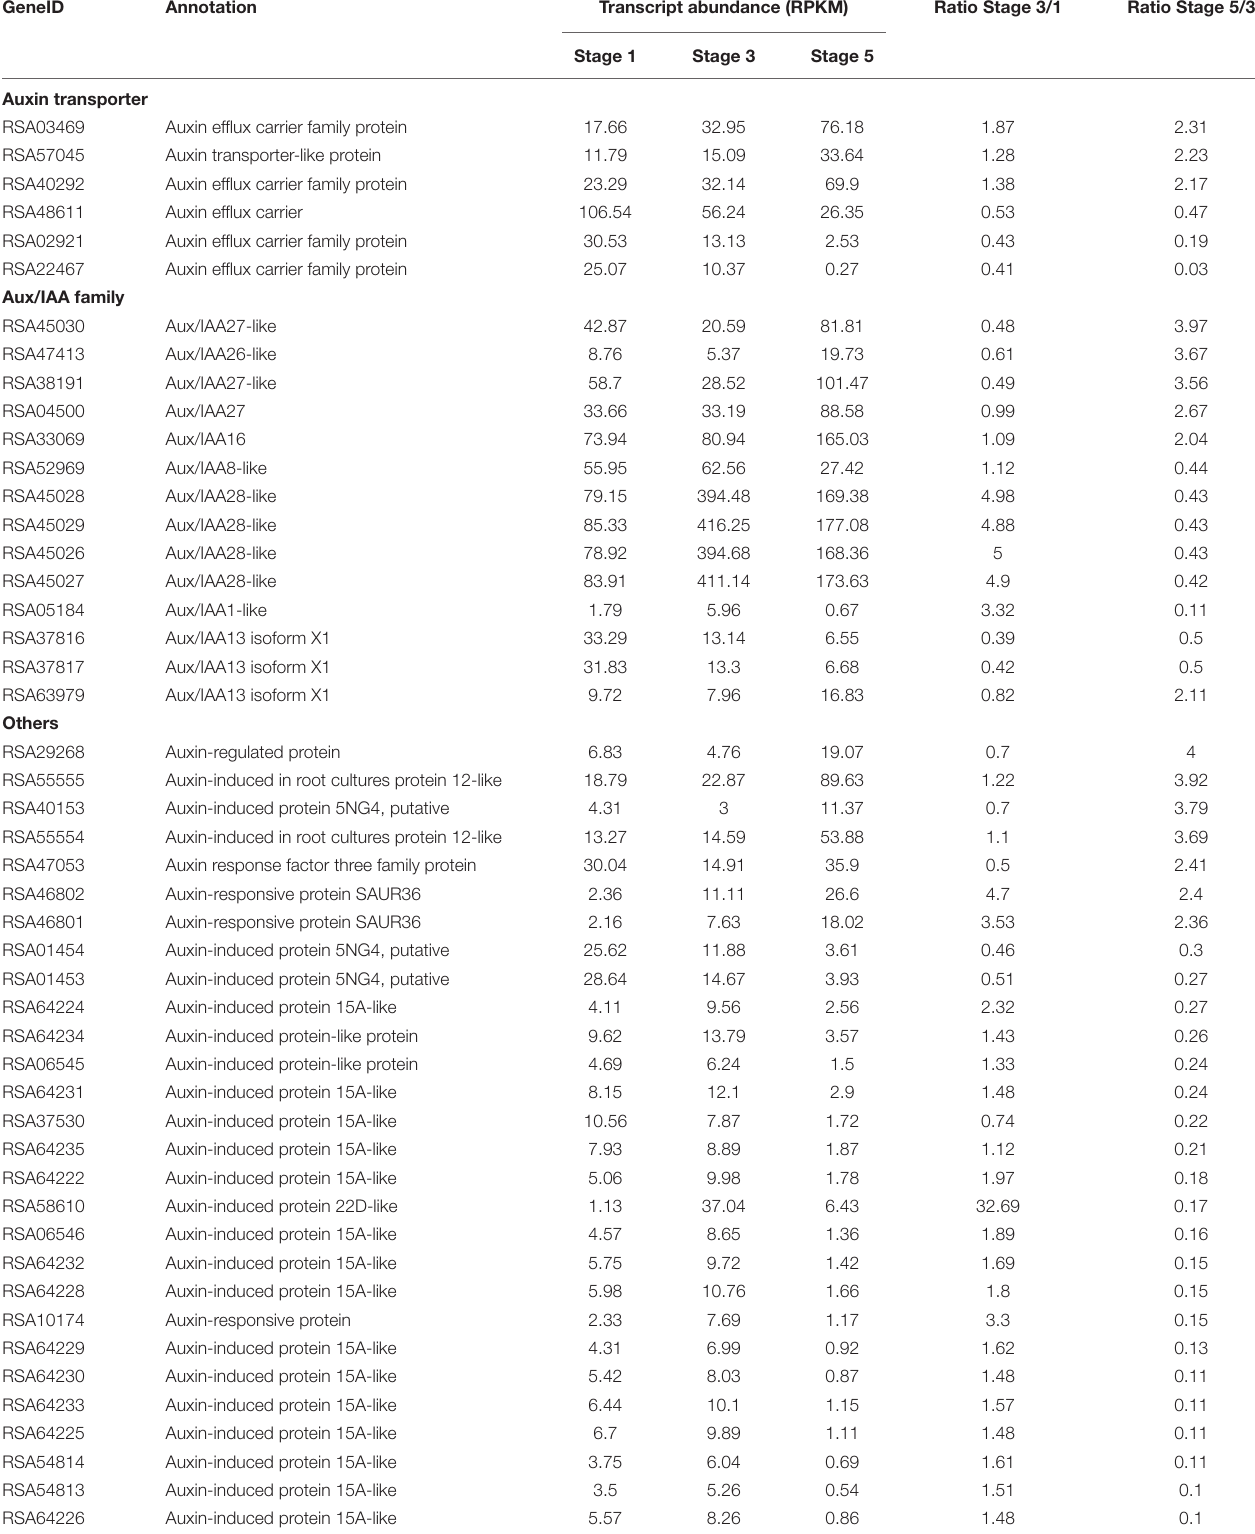
TABLE 2 | Expression changes of transcripts related auxin pathway in response to abscission.